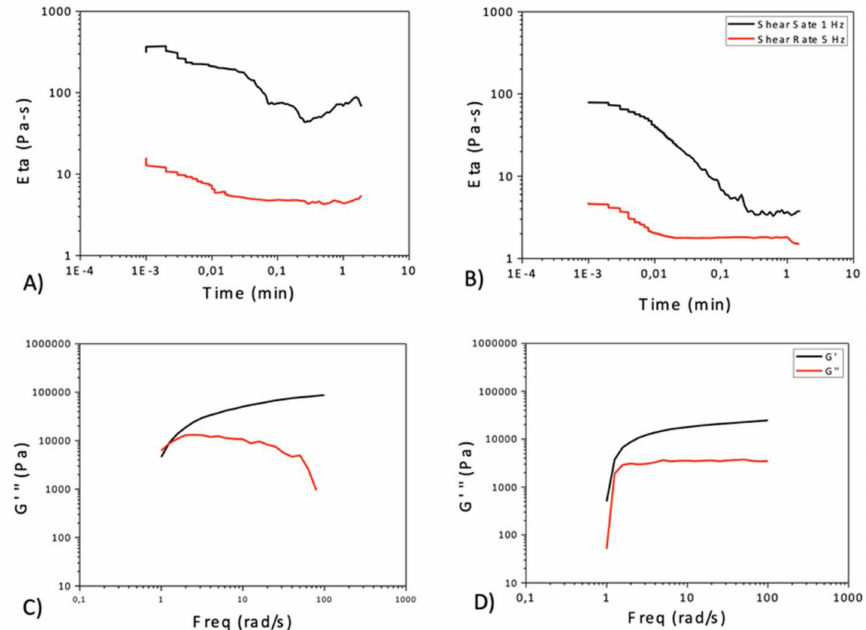
Figure 5. ( A , B ) Relationship between viscosity and time at different values of the applied shear rate (1 Hz and 5 Hz, in black and red, respectively), for the two cellulose acetate solution (10% ( A ) and 5% ( B ) concentrated). ( C , D ) Elastic module G’ (in black) and viscous module G” (in red) as a function of frequency, for both cellulose acetate solutions (10% ( C ) and 5% ( D ),